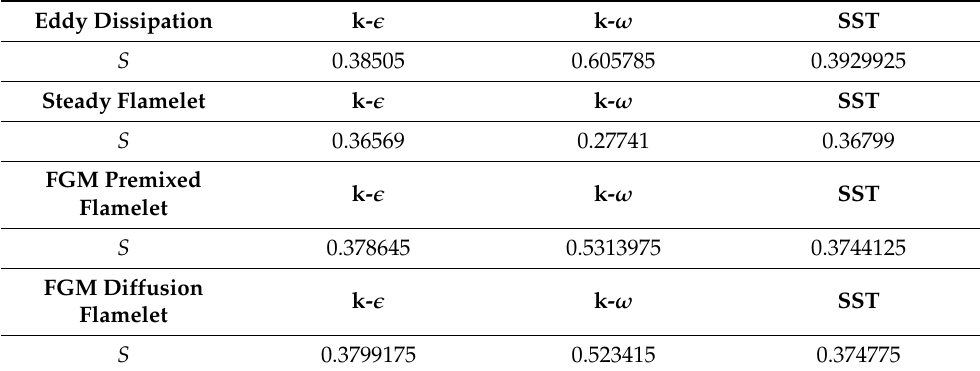
Table 3. Swirl number for the combustion and turbulence models